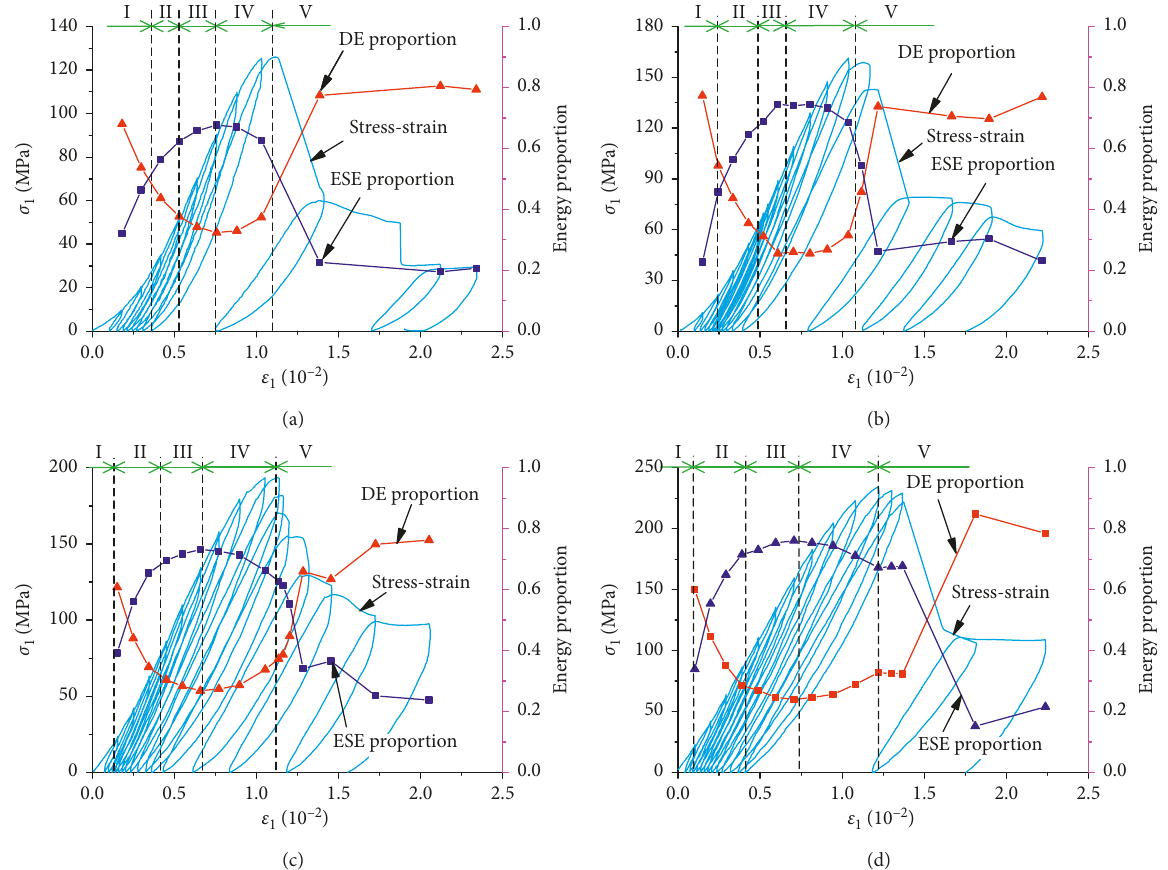
Figure 8: Energy proportion-strain curves with confining pressures of 5 MPa (a), 10MPa (b), 20MPa (c), and 30MPa